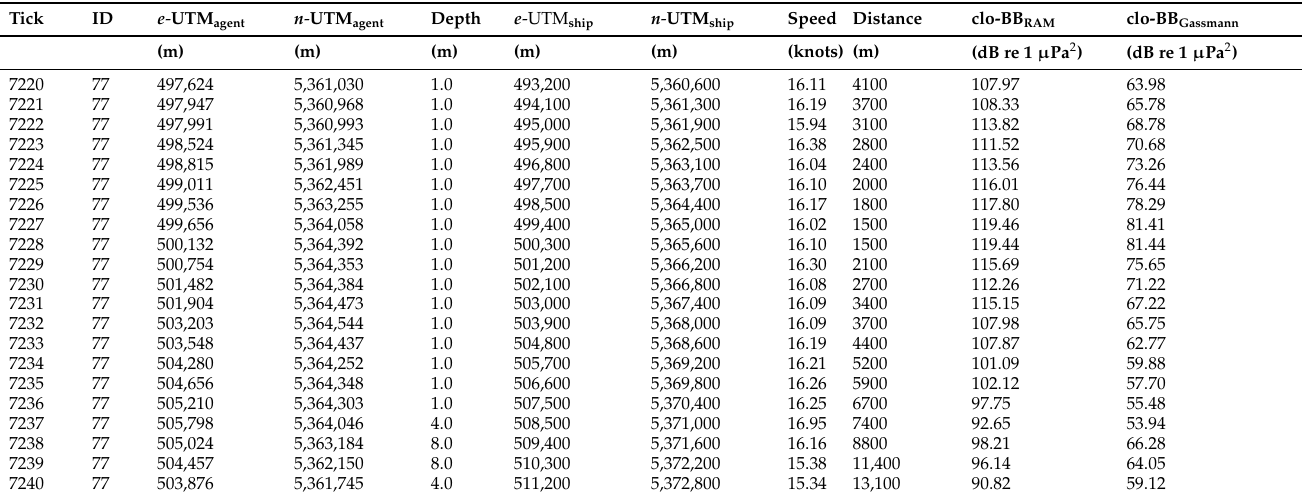
Table A3. That value could be compared to the clo-BB RAM standard in the second-to-last column of Table A2. Differences are listed in Table A3’s right-hand column. In this example for timesteps 7220 to 7240 of the 9 February 2021 run, uncertainties on the clo-BB INTERP calculations as replacement values for dismissed clo-BB RAM were, on average, below 2 dB re 1 µ Pa 2 in absolute value for the estimation of the RL received by agent ID 77. Table A2. Example—Agent’s and ship’s